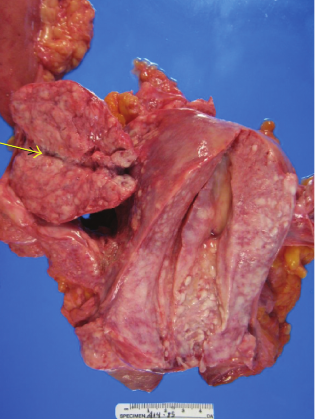
Figure 4: Tumor mass (arrow), left side of the bladder. Extensive metastases to lymph nodes with normal urothelium.